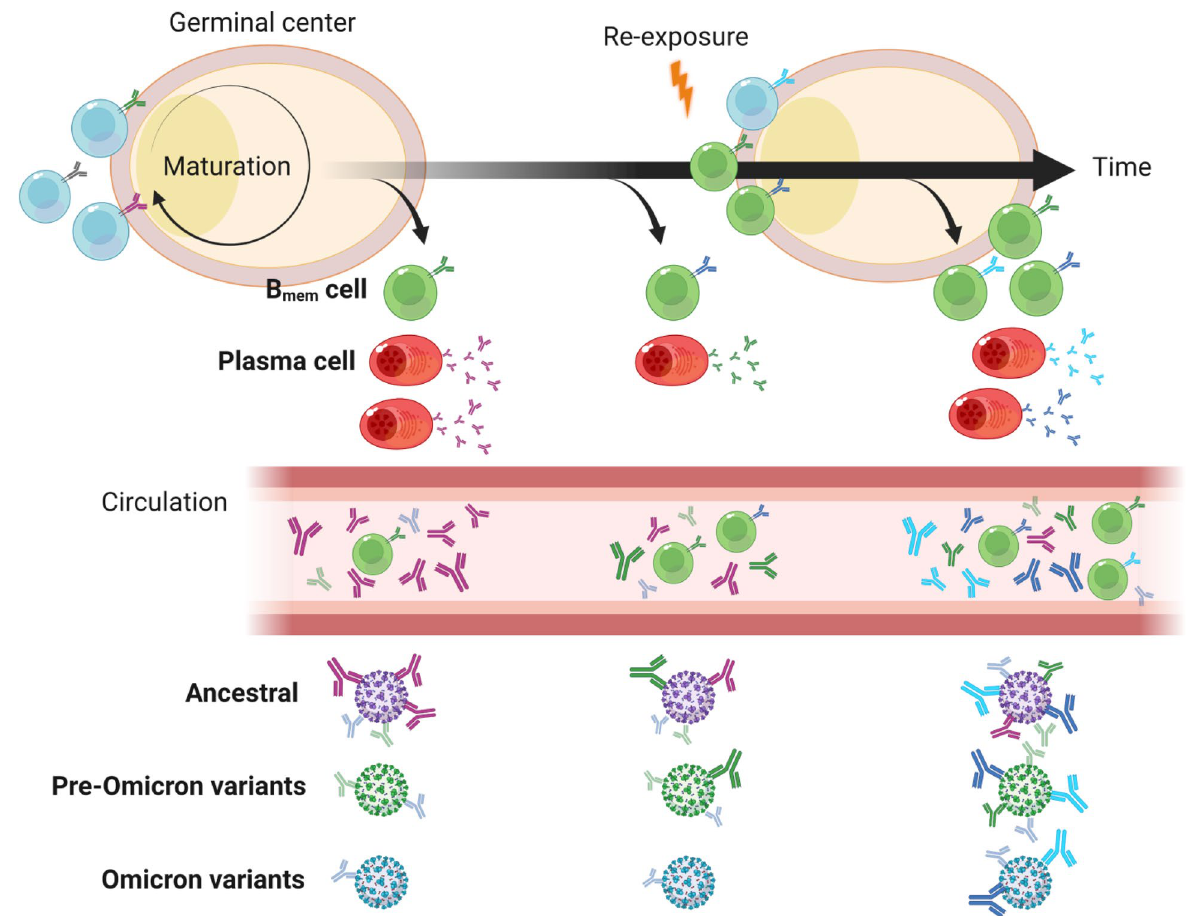
Fig. 3 Evolution of humoral immune responses to SARS-CoV-2. B mem cells evolve their BCRs over time to acquire the breadth to pre-Omicron variants. The BCR breadth is further expanded to Omicron variants after re-exposures by vaccination or infection. These processes may play a pivotal role in durable and broad protection against SARS-CoV-2 variants that emerge in the future. The figure was created with